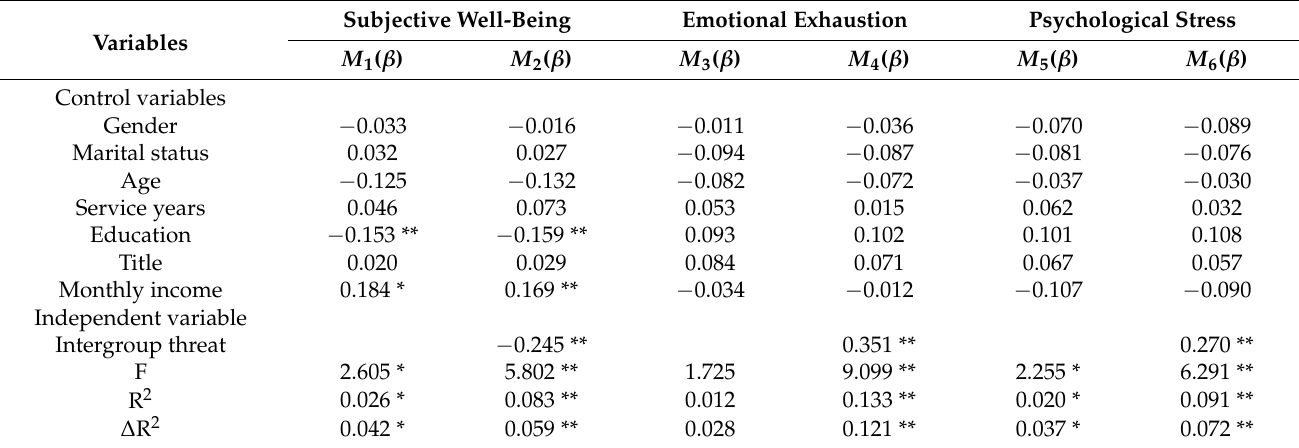
Table 6. Hierarchical linear regression models for organizational psychology ( n = 423).